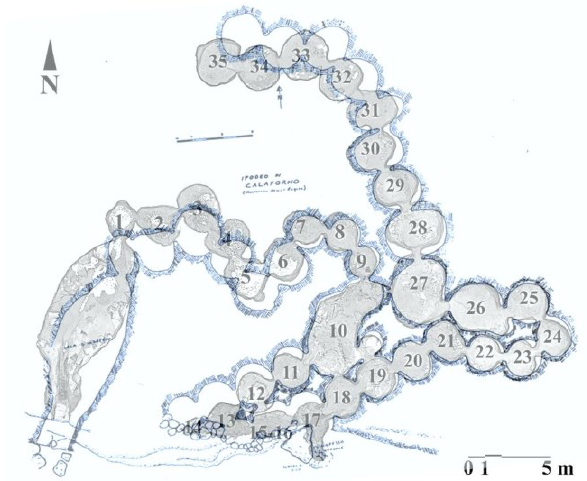
Figure 6 . Overlap between the orthophoto, in grey, obtained by P30-BLK2GO final point cloud (2021) and, in blu, two- dimensional representation of Guzzardi (1980).